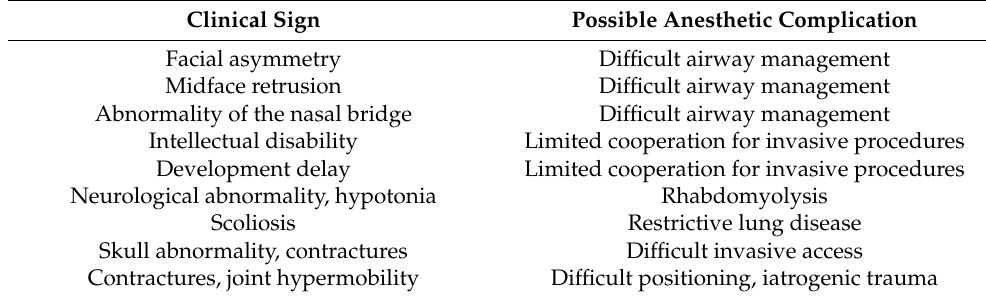
Table 1. The frequent clinical signs and symptoms of Zhu-Tokita-Takenouchi-Kim syndrome and associated possible anesthetic